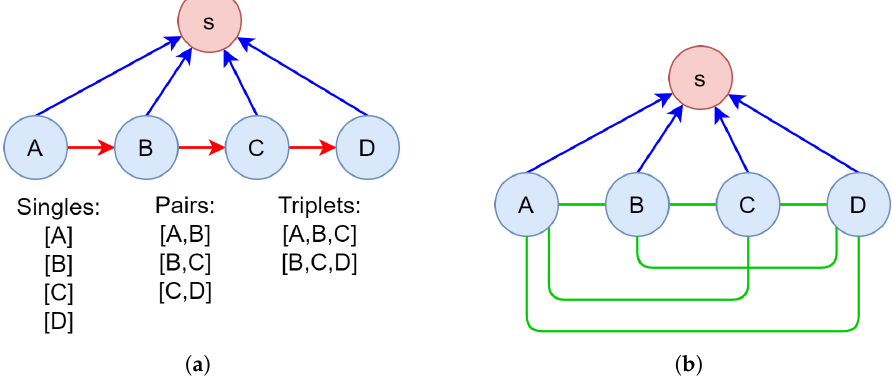
Figure 1. Representation of items (light blue nodes), sessions (pink nodes) and the relationships ItemInSession (blue edges), Next (red edges), InSameSession (green edges). ( a ) The HSP Graph Model, ( b ) The RIC Graph